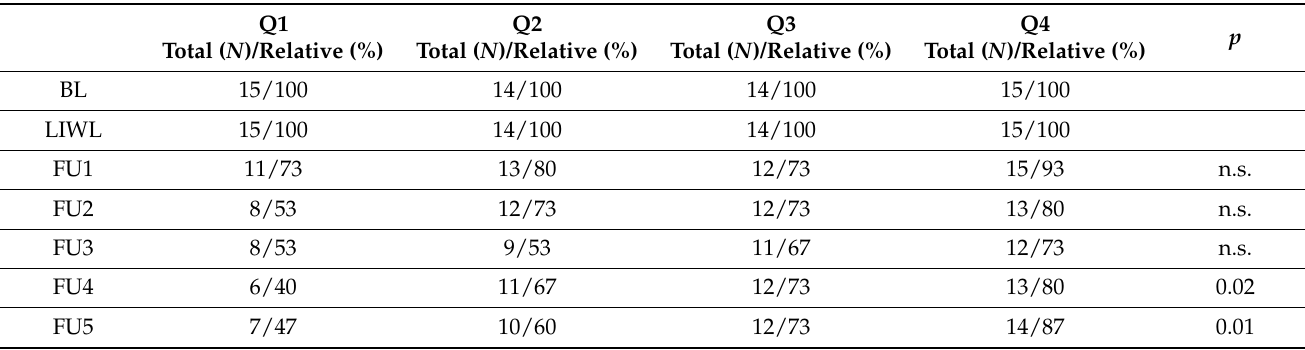
Table 1. Table showing the absolute ( N ) and relative (%) numbers of participants in each quartile (Q1–Q4) at each timepoint.